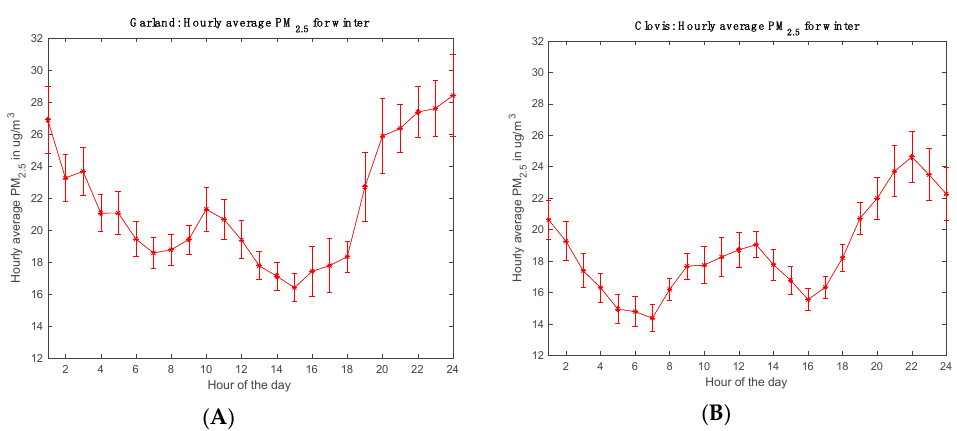
Figure 6. Variation in hourly average PM 2.5 when all winters are averaged together.